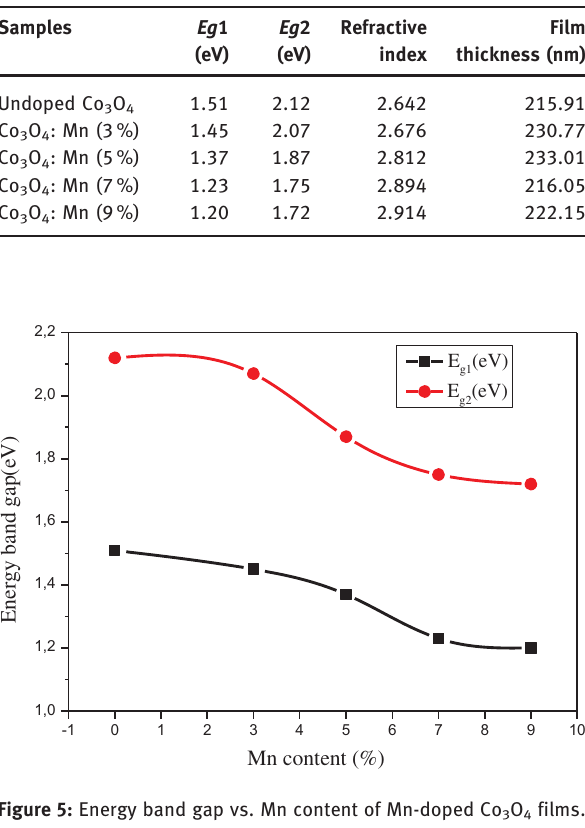
Figure 5: Energy band gap vs. Mn content of Mn-doped Co 3 O 4 films.